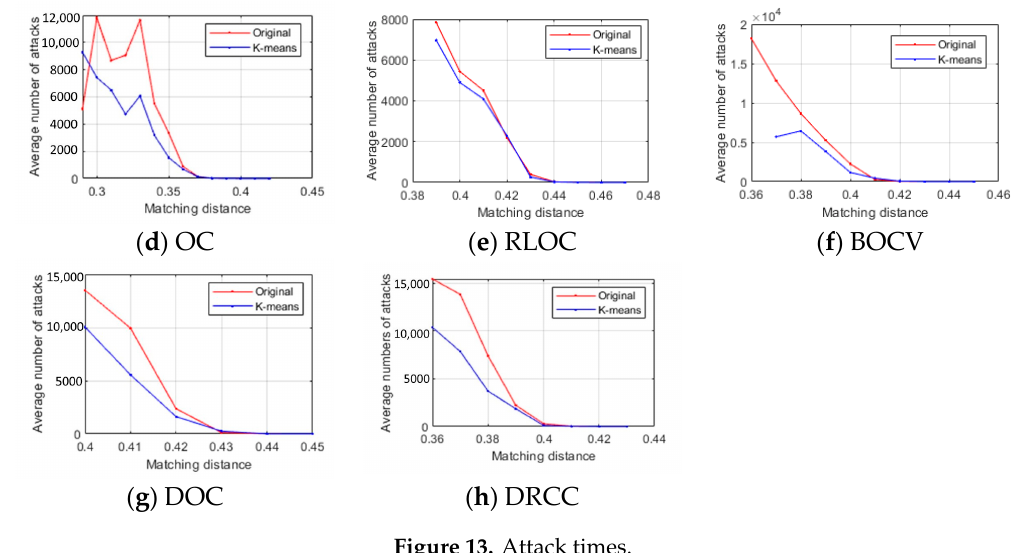
Figure 13. Attack Figure 13. Attack times. Figure 13. Attack times.